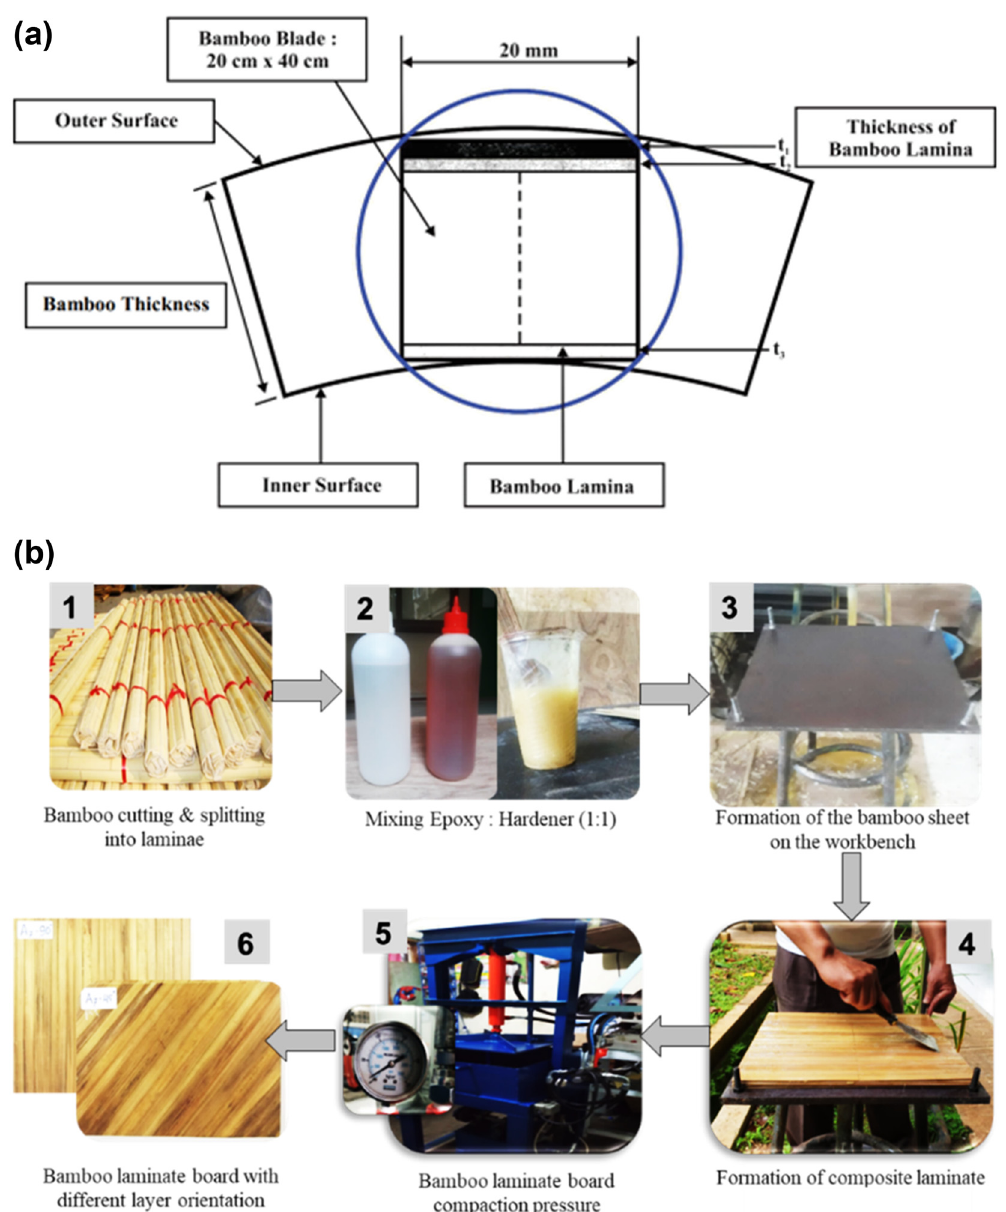
Figure 3: ( a ) Laminae shape of the Apus bamboo and ( b ) LBC making process [ 1 ]